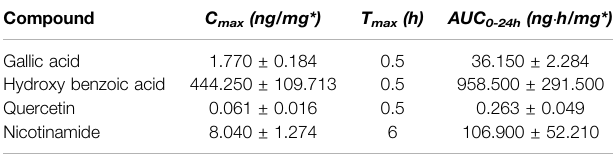
TABLE 3 | Pharmacokinetic parameters of the selected compounds in the retina.